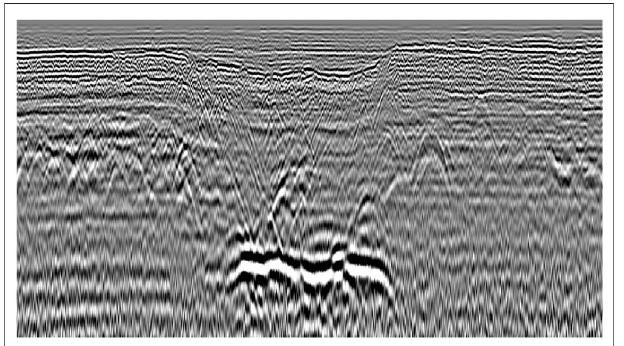
FIGURE 2 | Longitudinal section of three-dimensional ground- penetrating radar.